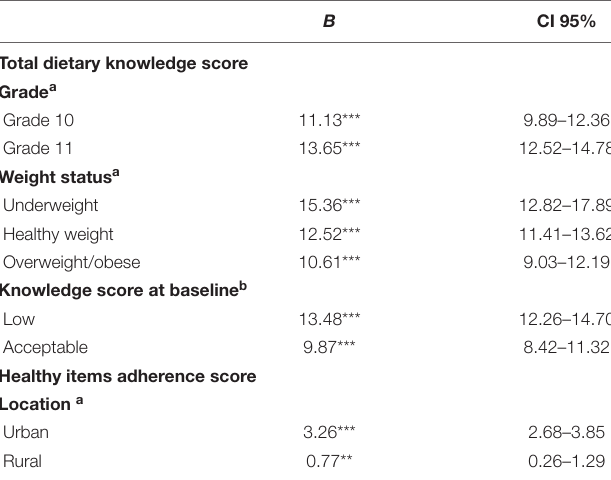
TABLE 3 | Intervention effects on the total knowledge score and healthy items adherence score of the indicated subgroups.